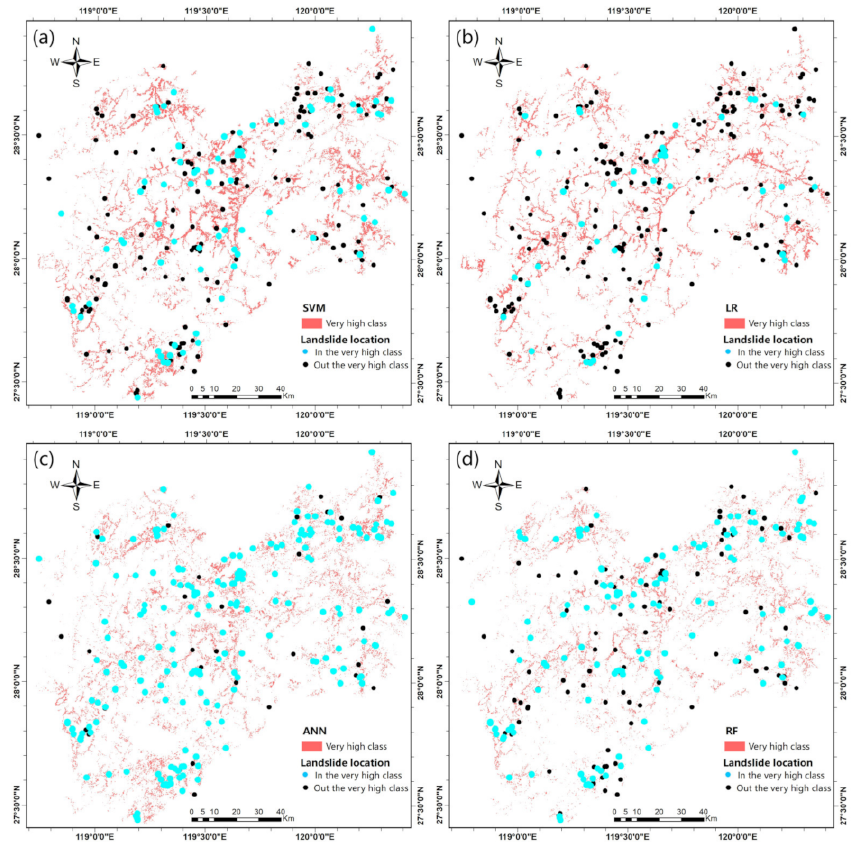
Figure 12. The very high susceptibility class areas of the landslide susceptibility maps: ( a ) SVM model; ( b ) LR model; ( c ) ANN model; and ( d ) RF